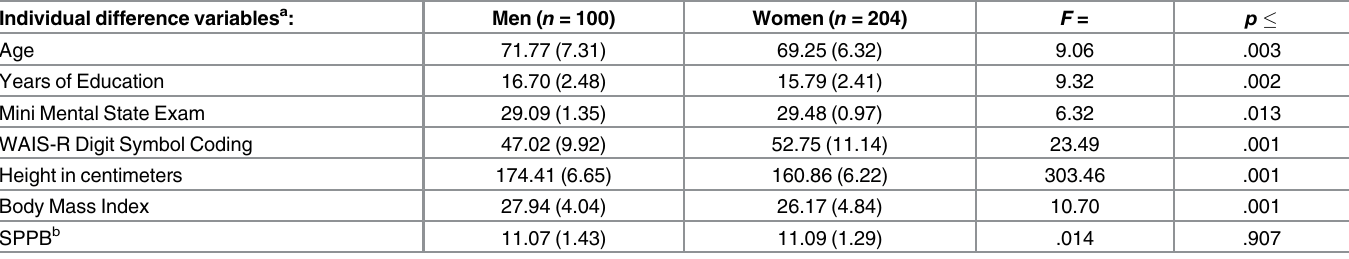
Table 1. Sex differences in age, education, cognitive functioning, and physical assessment measures.